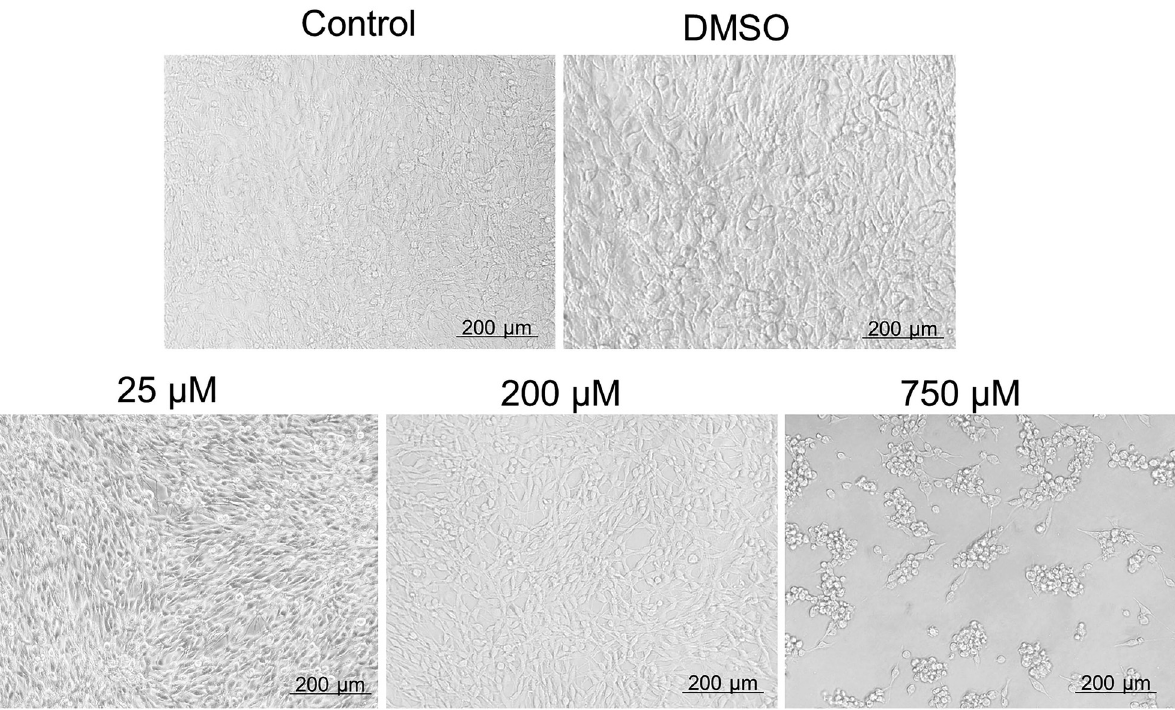
Figure2: Cellswereimagedusinganinvertedphasecontrastmicroscope48hpostTMZexposure.DistinctcelldeathobservedinU87MGcells following treatment with 25, 200, and 750 µM TMZ. Magni fi cation, × 20, Scale bar, 200 μ